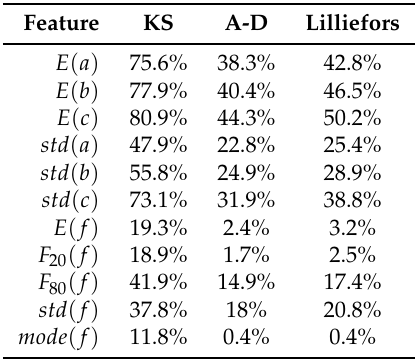
Table 1. Gaussian Test. Percentage of Gaussian distributed features.